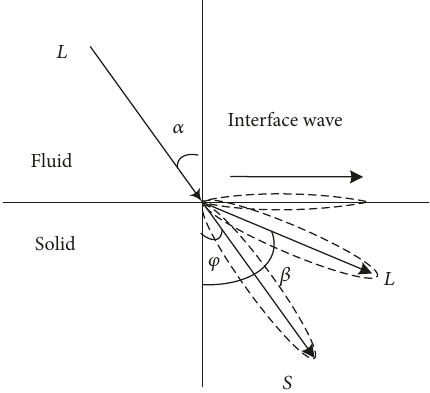
Figure 2: Refraction and wave mode conversion.